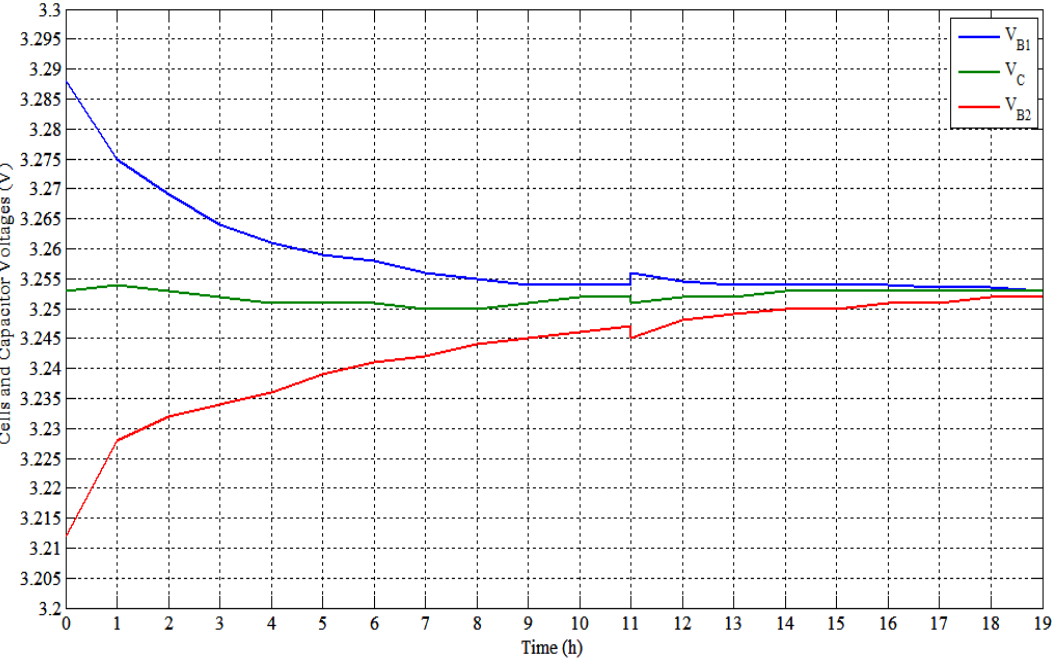
Figure 33. Experimental results of 2.3 A·h cells with SSC balancing (Test No.